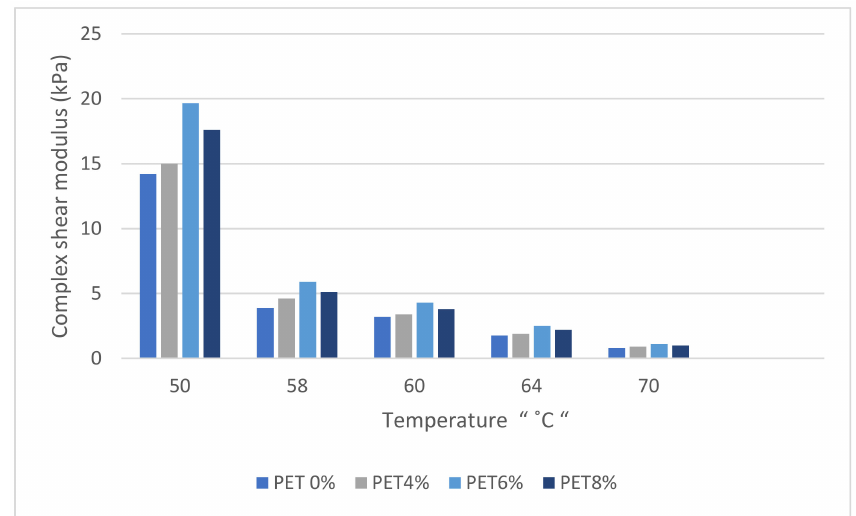
Figure 2. Complex shear modulus results of unaged PET-modified binders.